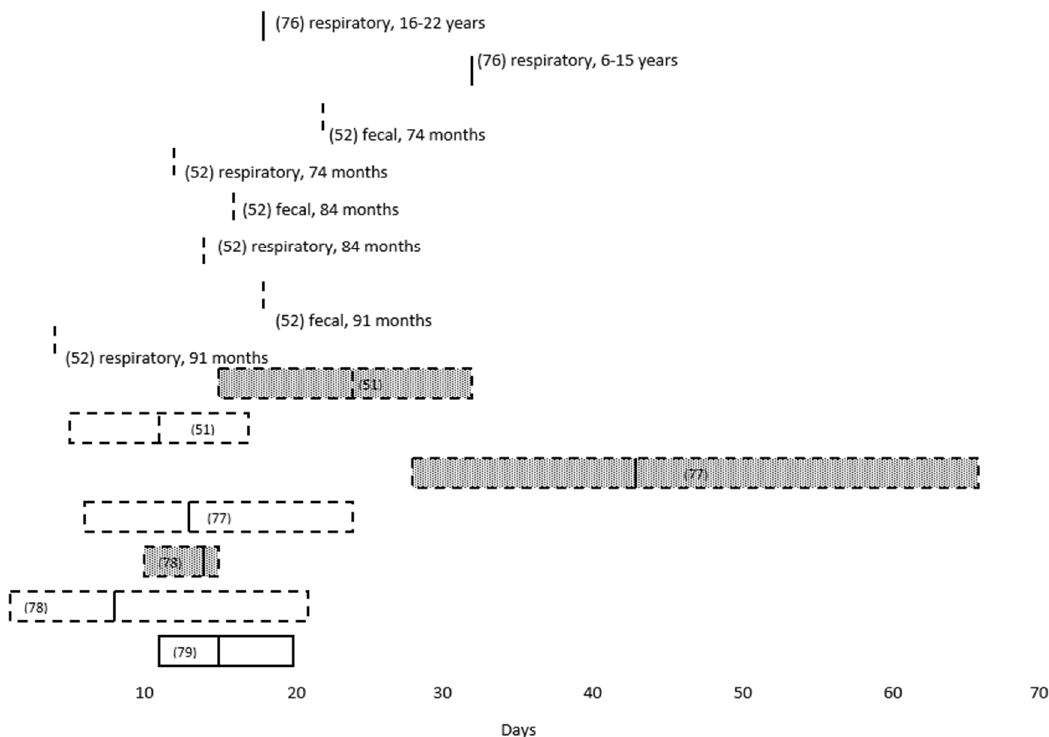
Figure 4. Duration of SARS-CoV-2 RT-PCR positivity in respiratory and fecal specimens reported in studies of pediatric COVID-19 patients cited in this review. The medians are indicated by a solid vertical line, and the means are indicated by a dashed vertical line. A solid box indicates interquartile range, and a dashed box indicates range. Unshaded boxes indicate respiratory specimens, and stippled boxes indicate fecal specimens. The study reference numbers are in parentheses. See text for additional details.